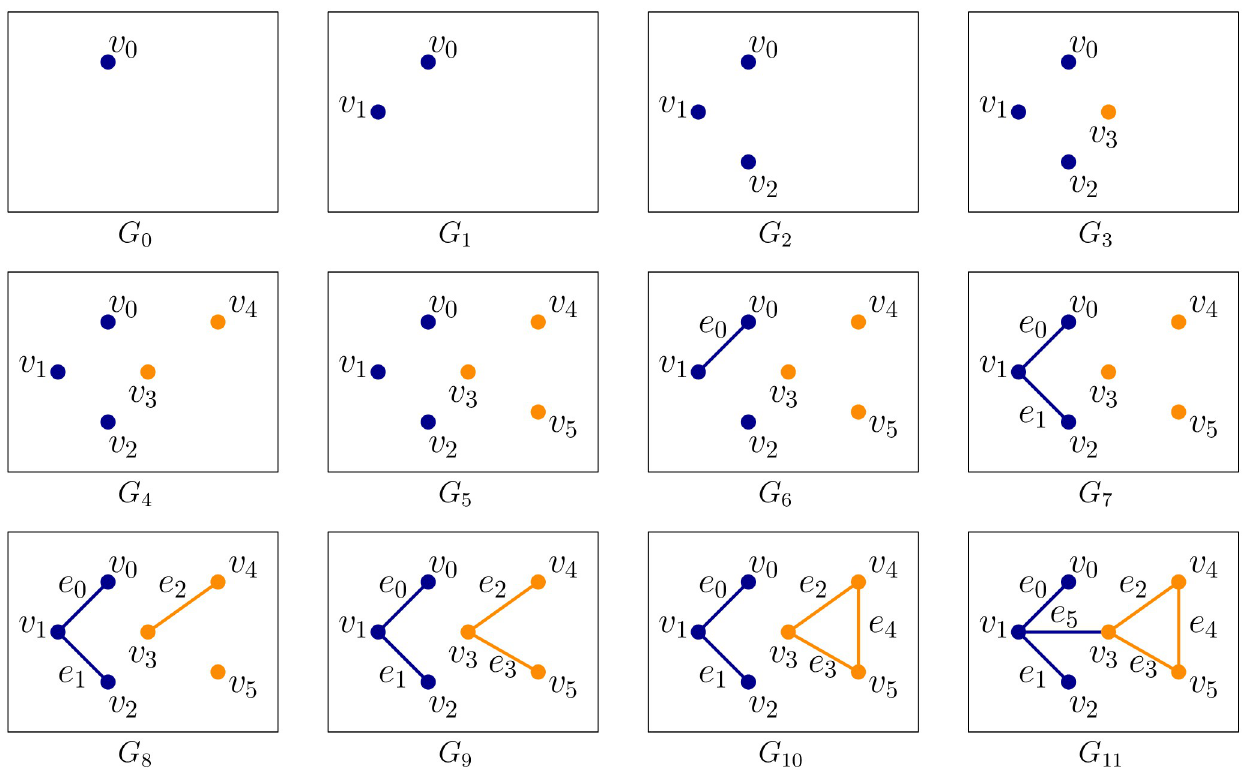
Fig 1. An example of filtration for a graph. The nested sequence of graphs G 0 � G 1 � ... G 11 forms a filtration of the final graph G 11 . Each vertex v a new component in the nested sequence, and edges e 0 , e 1 , e 2 , e 5 merge two components whereas e 4 creates a cycle (yellow).